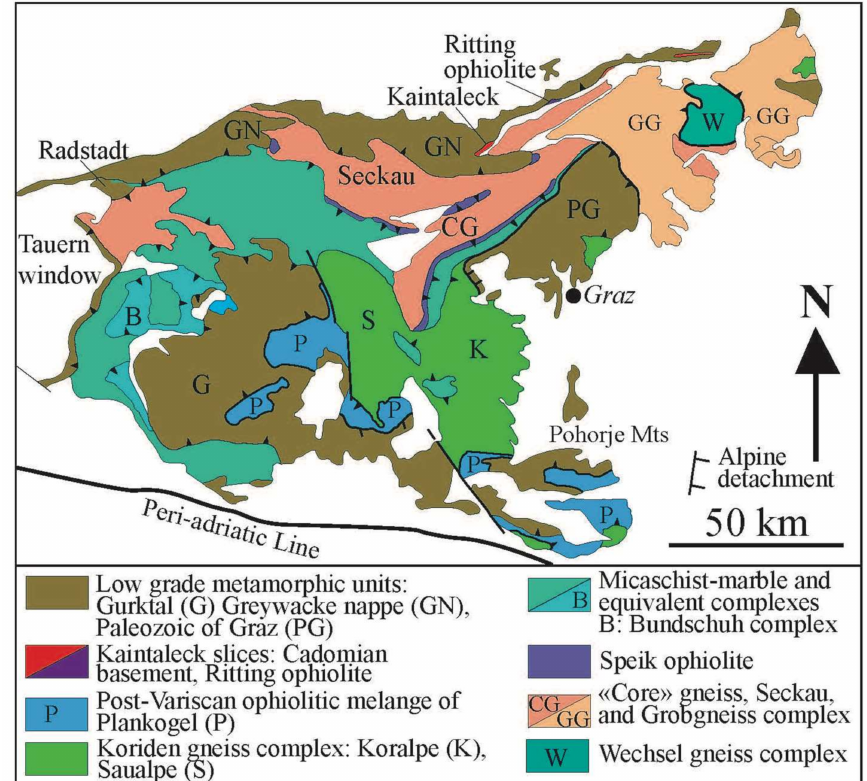
Figure 9. Tectonic map of the Austroalpine Domain east of the Tauern window. The Ritting, and Speik ophiolites subdivide the Variscan units into three main groups, namely: (i) the low-grade metamorphic units (Gurktal nappe, Greywacke nappe, and Paleozoic of Graz), (ii) the Koriden gneiss, and Micaschist–marble complexes, and (iii) the “Core” gneiss, Grobgneiss, and Wechsel gneiss complexes (simplified from [118]). For the interpretation of nappe architecture, see Figures 10 and 11.